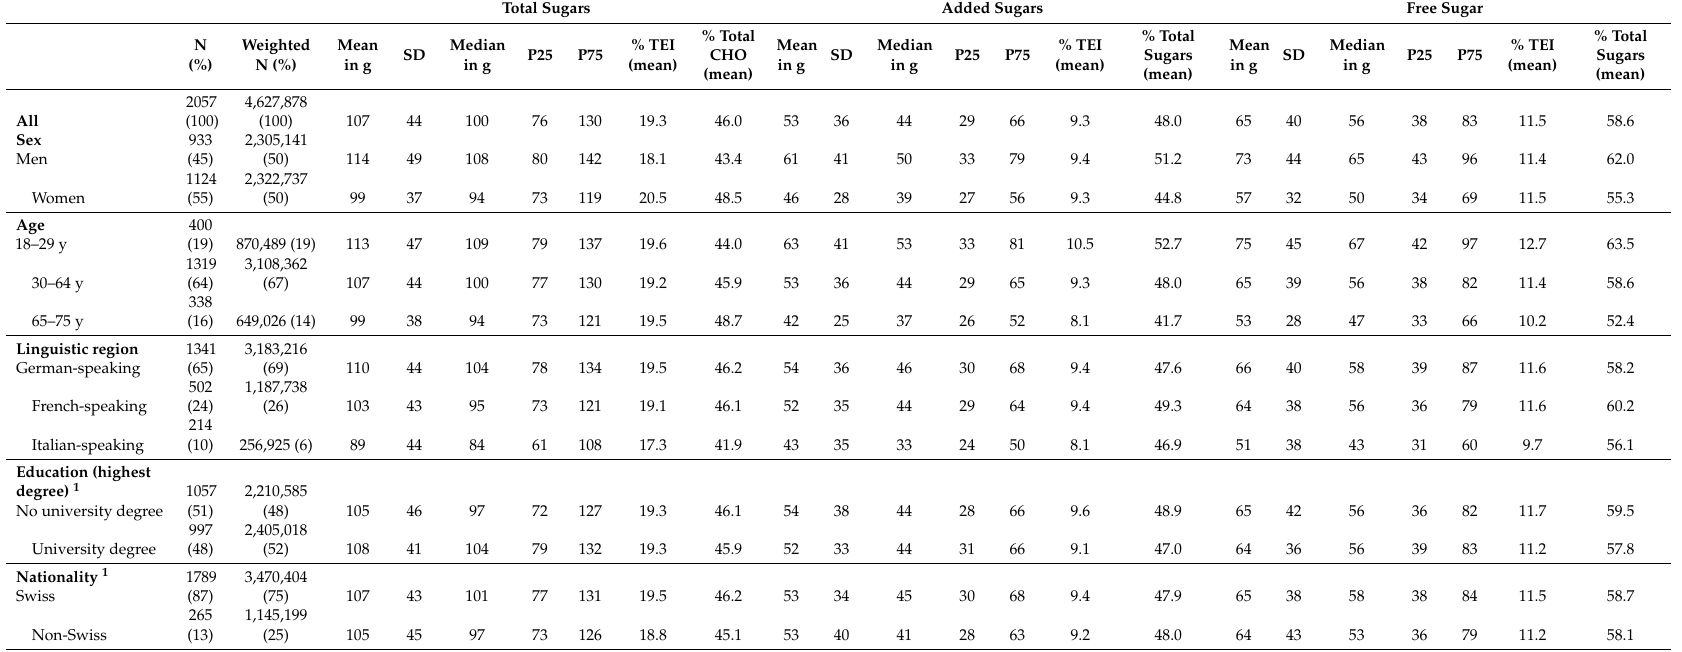
Table 1. Weighted habitual intakes of total, added, and free sugars. TEI: total energy